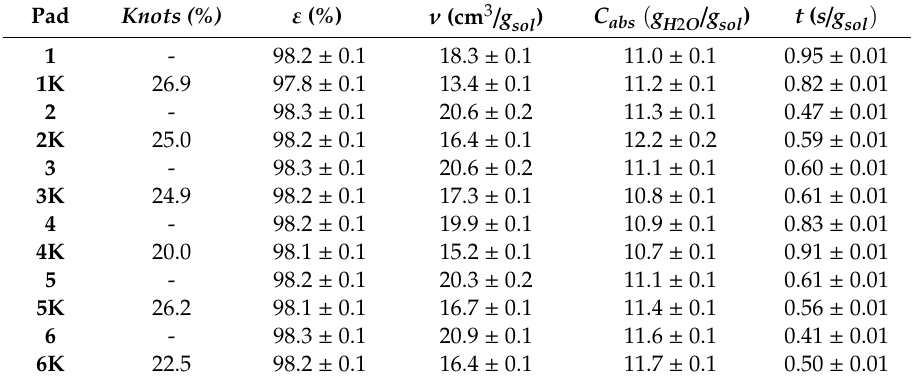
Table 8. Porosity, specific volume, absorption capacity and absorption time of pads formed from pulps without ( 1 – 6 pads) and with ( 1K – 6K pads)